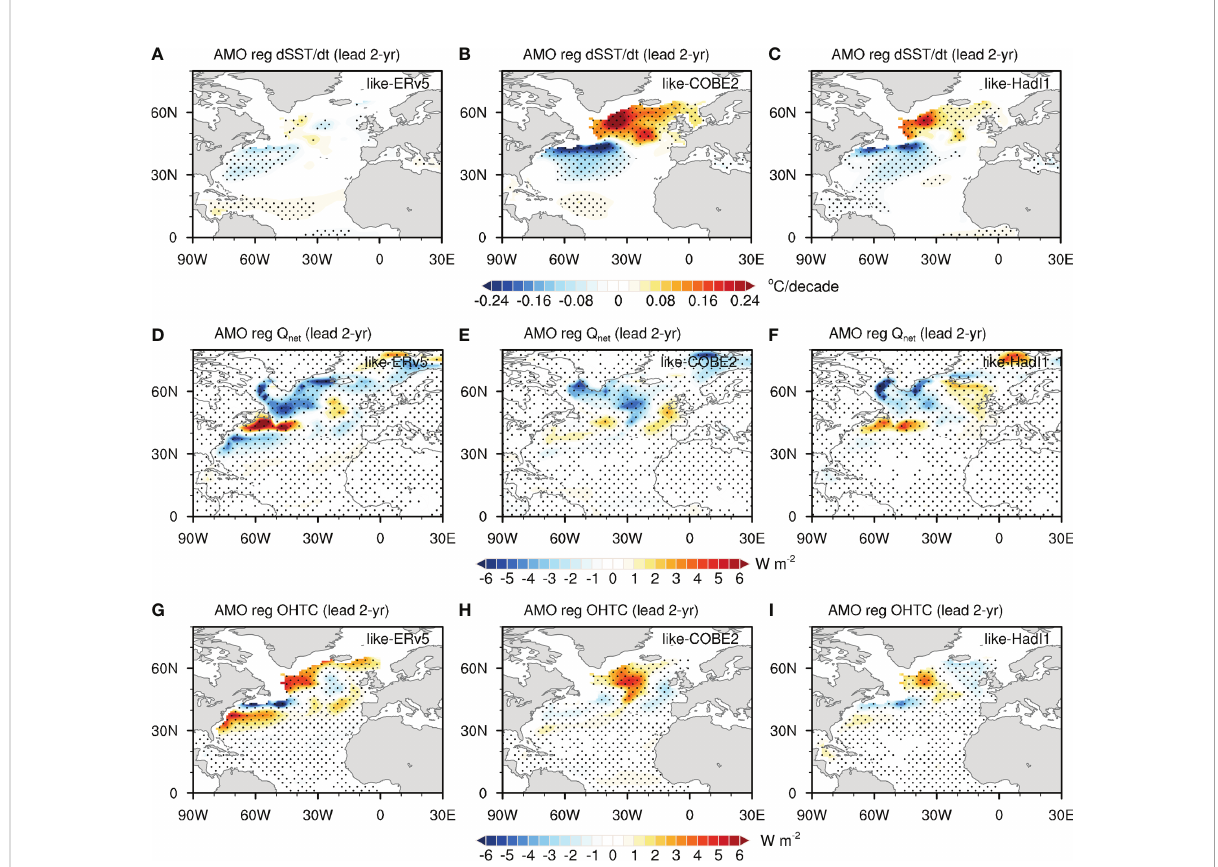
FIGURE 9 The (A, D, G) SST tendency, (B, E, H) net surface heat fl ux Q ' net , and (C, F, I) oceanic heat transport convergence OHTC ', regressed on the AMO index in selected members of CESM2 piControl with a 2-year lead time, respectively. The downward direction is positive for Q ' net